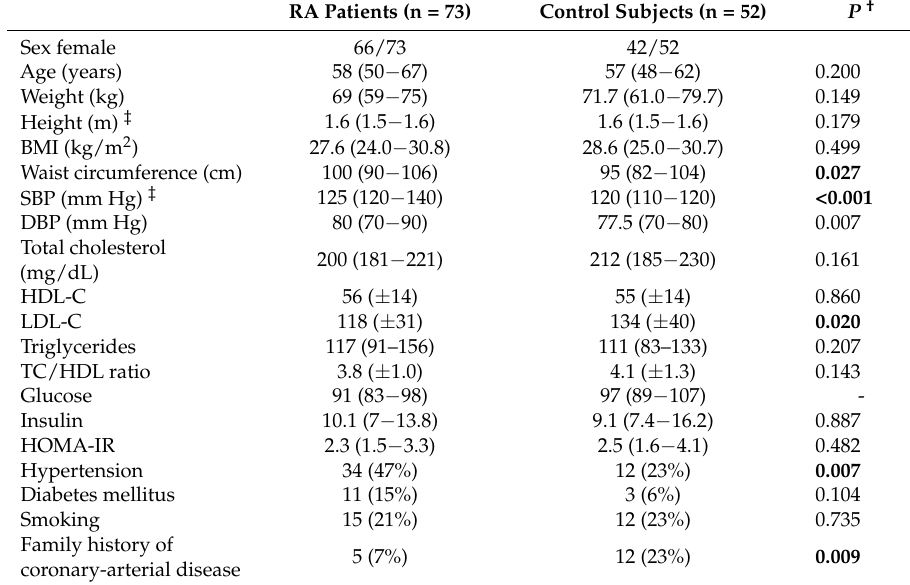
Table 2. Individual CVD risk factors in patients and healthy